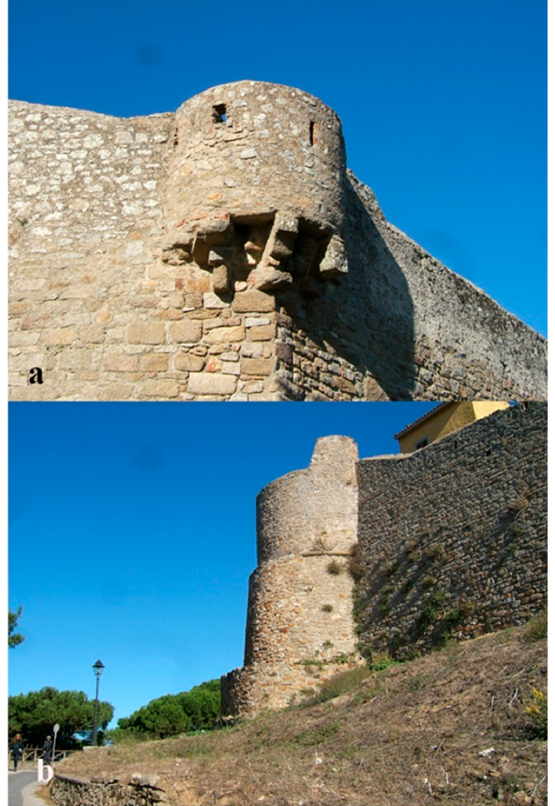
Figure 3. Giglio Castello: walls of the 16th century, built with granite ashlars (a). Giglio Castello: detail of a tower of the city walls resting on a granite outcrop (b).